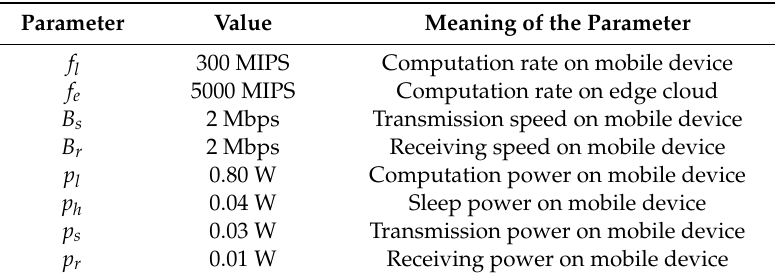
Table 1. The value of